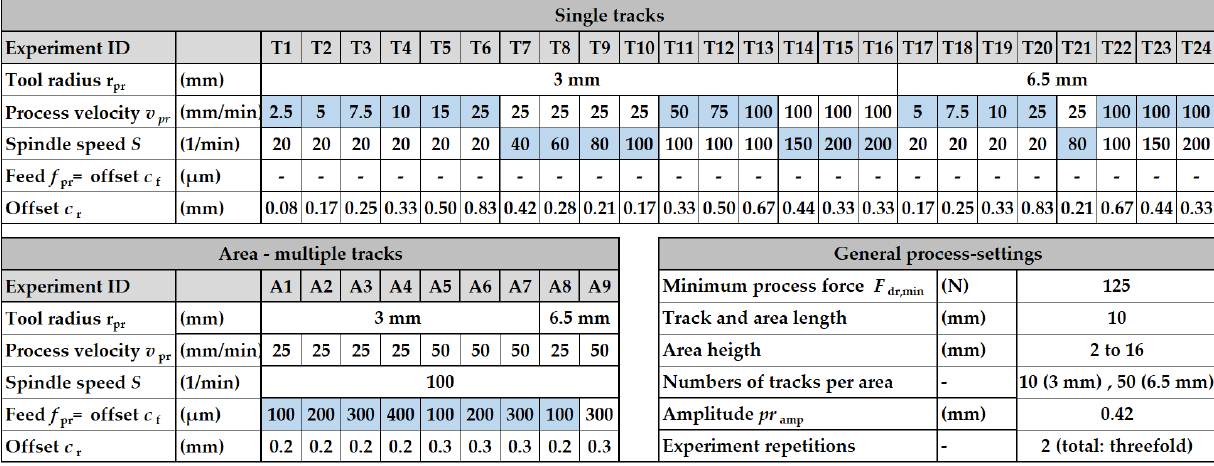
Figure 5. Experimental setup for experiments using tool type 1, the used process parameter to vary the offset c r is marked blue.